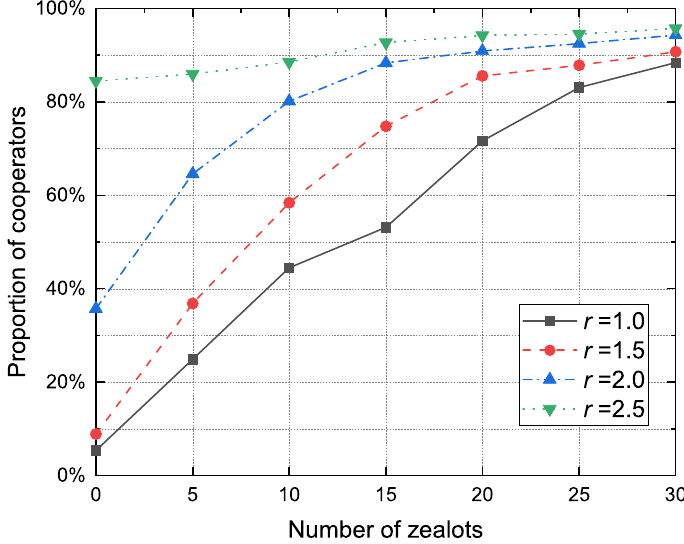
Figure 10. The proportion of cooperators to the synergy factor r for different zealot